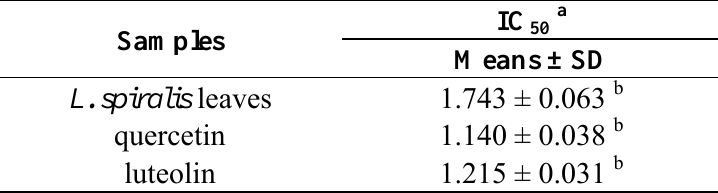
Table 1. 50% Inhibitory Concentration (IC the ABTS (2,2'-azinobis-(3-ethylbenzothiazoline-6-sulfonic acid)) radical test.